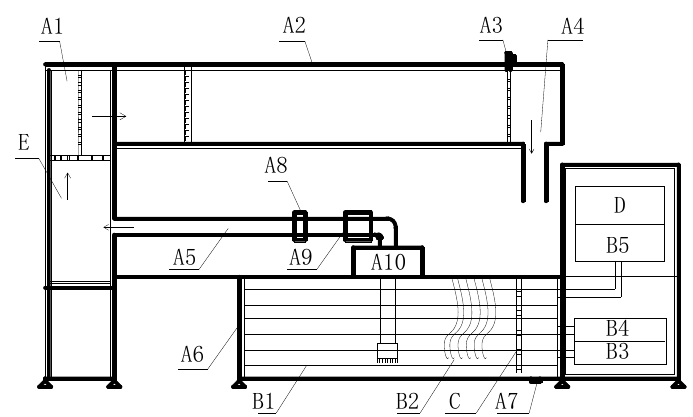
Figure 1. Structural schematic diagram of multifunctional open channel hydraulics test equipment.